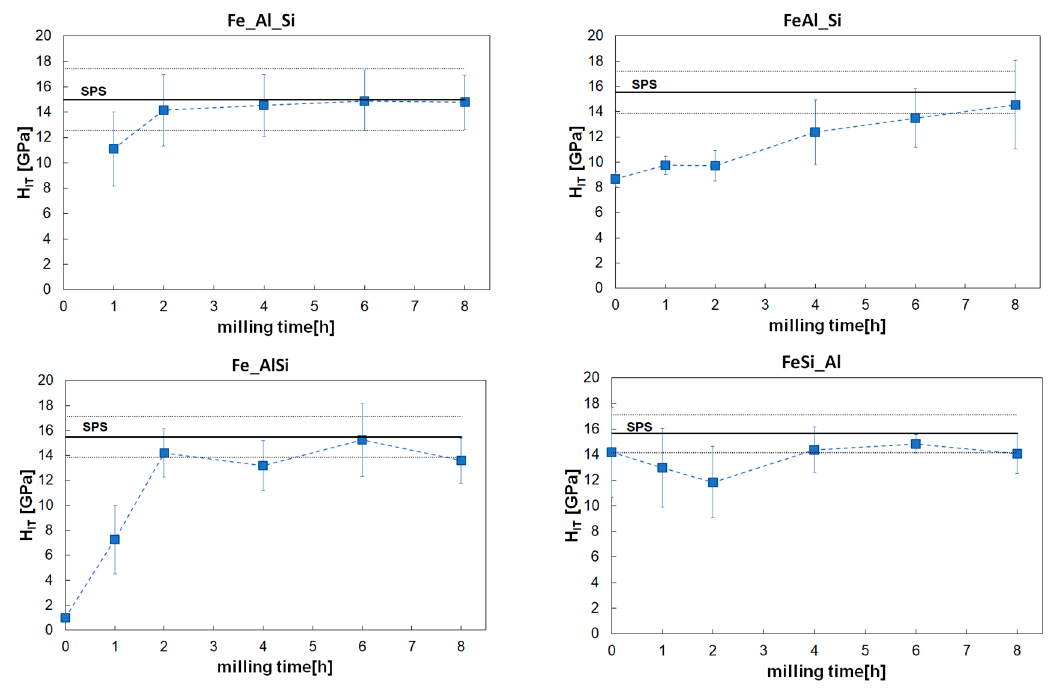
Figure 8. Hardness of the powder mixtures in different stages of mechanical alloying (solid horizontal line shows the value of the compacted sample measured at the maximum load of 2 mN, dotted lines represent the error bars).